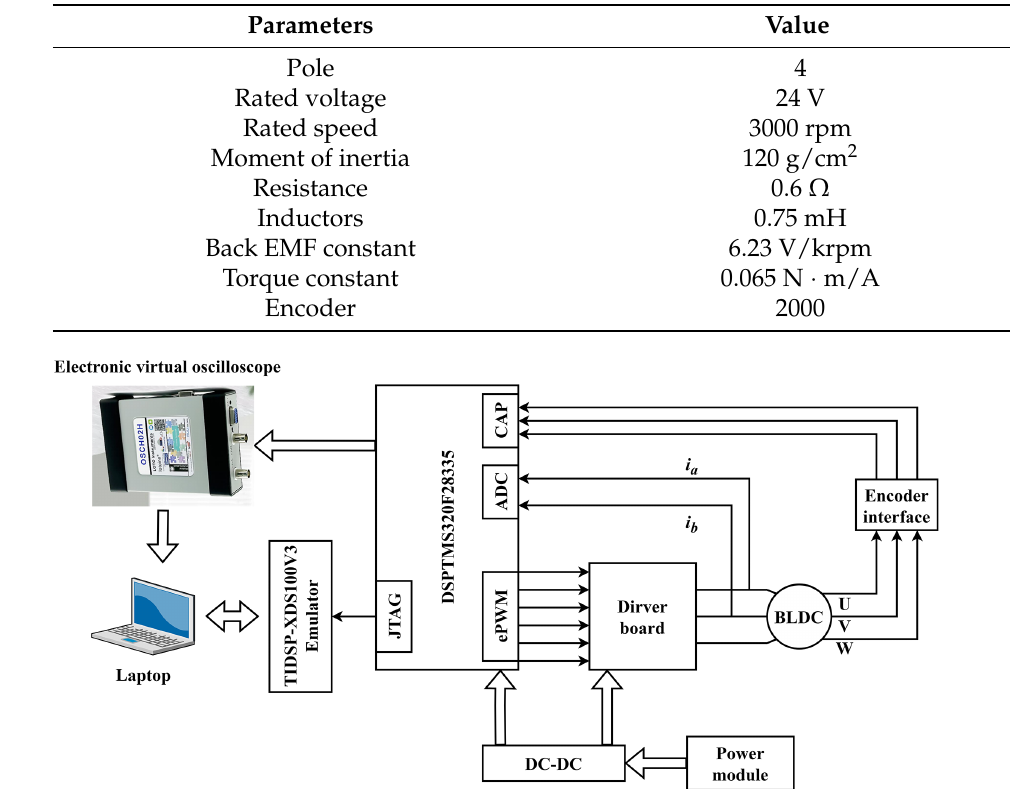
Table 1. BLDC motor parameters.